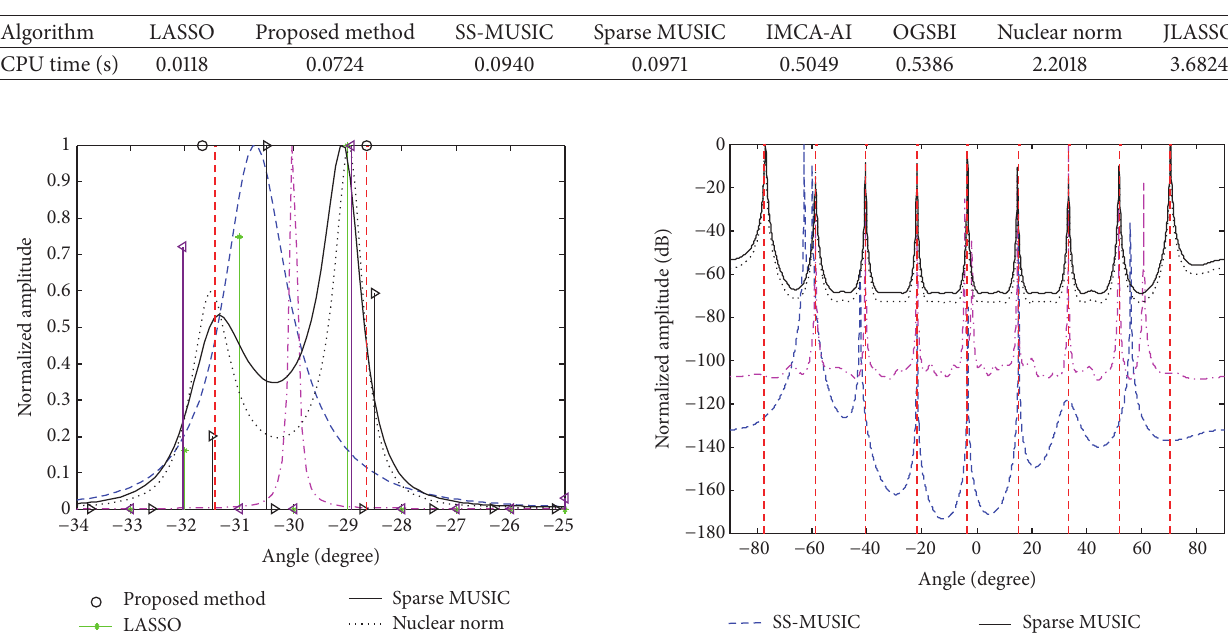
Table 2: CPU times of the eight methods.